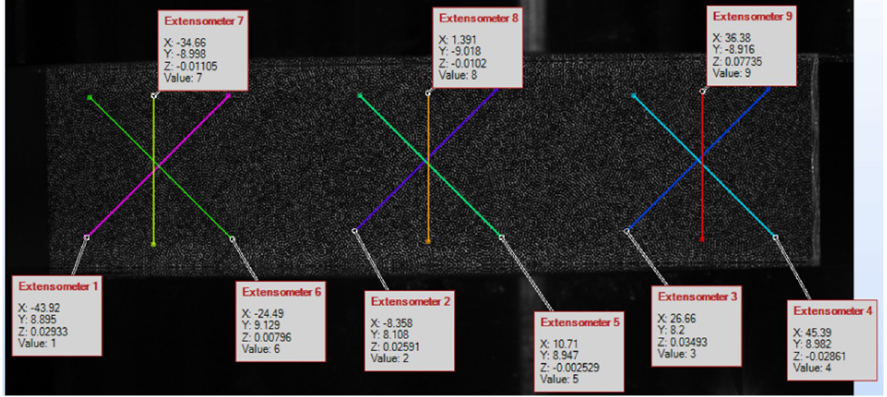
Figure 9. Location of each strain gauge on the sample in the test in the 45° direction.